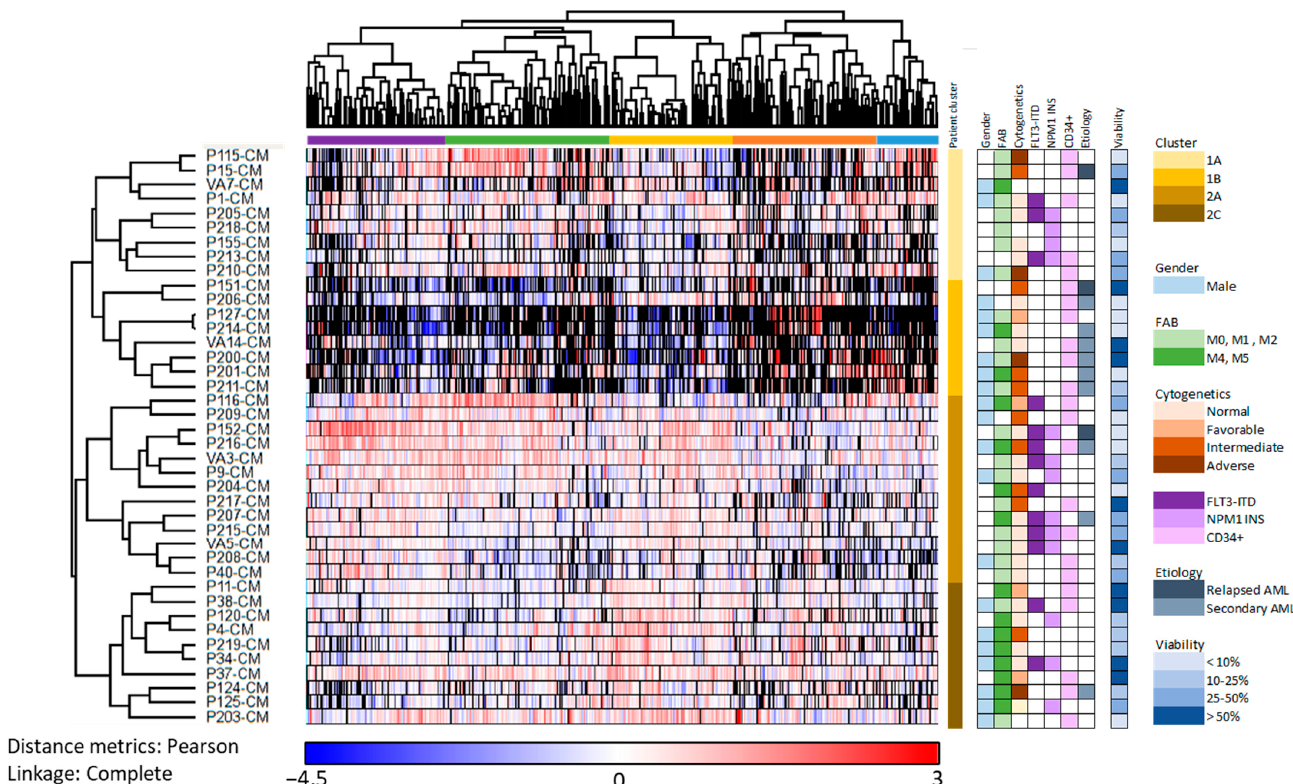
Figure 4. Identification of AML patient subsets based on their constitutive protein release during in vitro culture; an unsupervised hierarchical cluster analysis including 40 patients and based on 1770 proteins detected for at least 50% of the patients. The cells were cultured for 48 h in serum-free medium before supernatants were harvested and the proteomic analyses performed. The patients clustered into two main clusters (yellow/upper and brown/lower; see the column on the right side of the clustering); each of these two main clusters had two subclusters (upper yellow/dark yellow and lower brown/dark brown, respectively). As can be seen from the upper part of the figure, the proteins clustered into five main clusters each including 392 proteins (Cluster 1, purple), 460 proteins (Cluster 2, green), 337 proteins (Cluster 3, yellow), 417 proteins (Cluster 4, orange) and 164 proteins (Cluster 5, blue), respectively. Patient characteristics are indicated to the right in the figure, and blank fields indicate information not determined. Black color in the cluster analysis indicates that the protein was not detected. Table 3. Hierarchical clustering of AML patients based on the constitutive protein release profiles of their leukemic cells during in vitro culture. The table gives an overview of the most significant